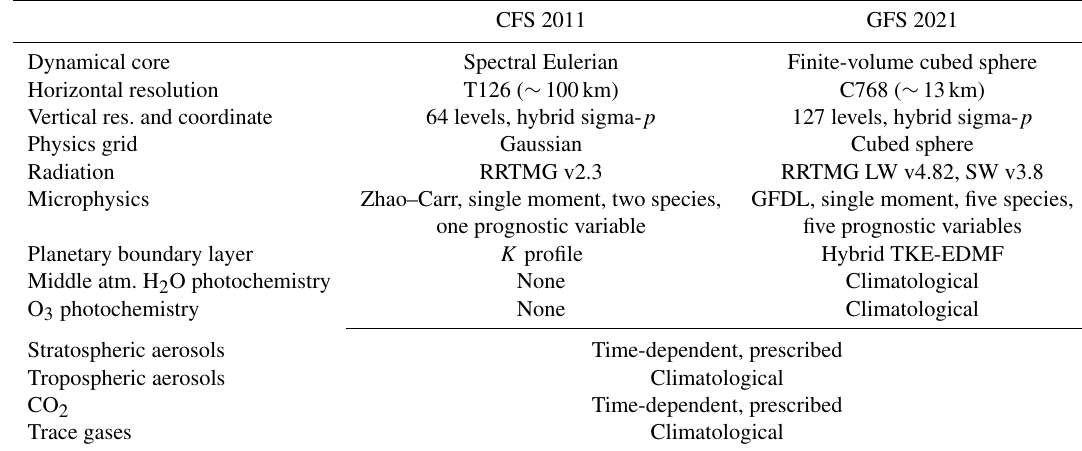
Table 1. Differences between the atmospheric component of 2011 NCEP CFS and the 2021 version of NCEP